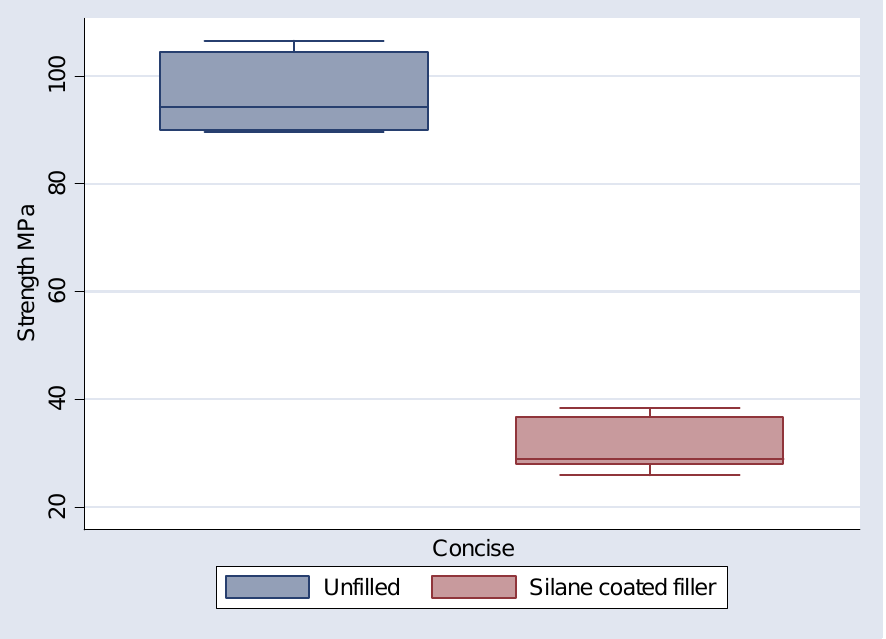
Figure 8. Boxplot of observed strengths (MPa) for Concise, unfilled and with silane coated